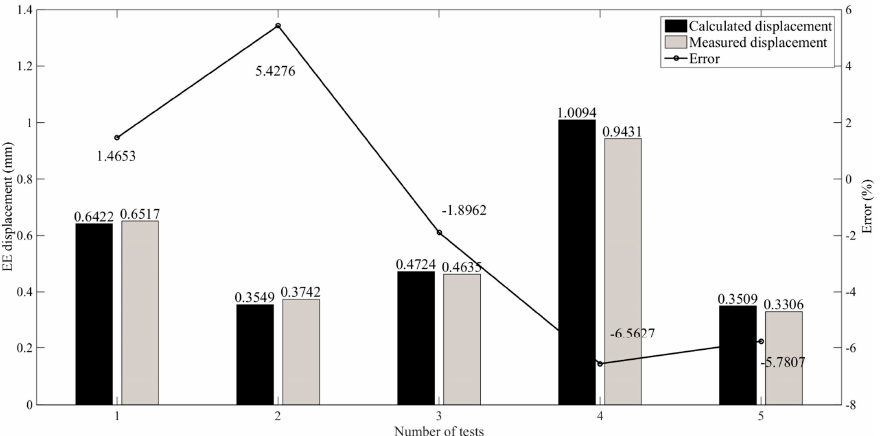
Figure 11. Calculated and measured displacements of the EE and the percentage of error.